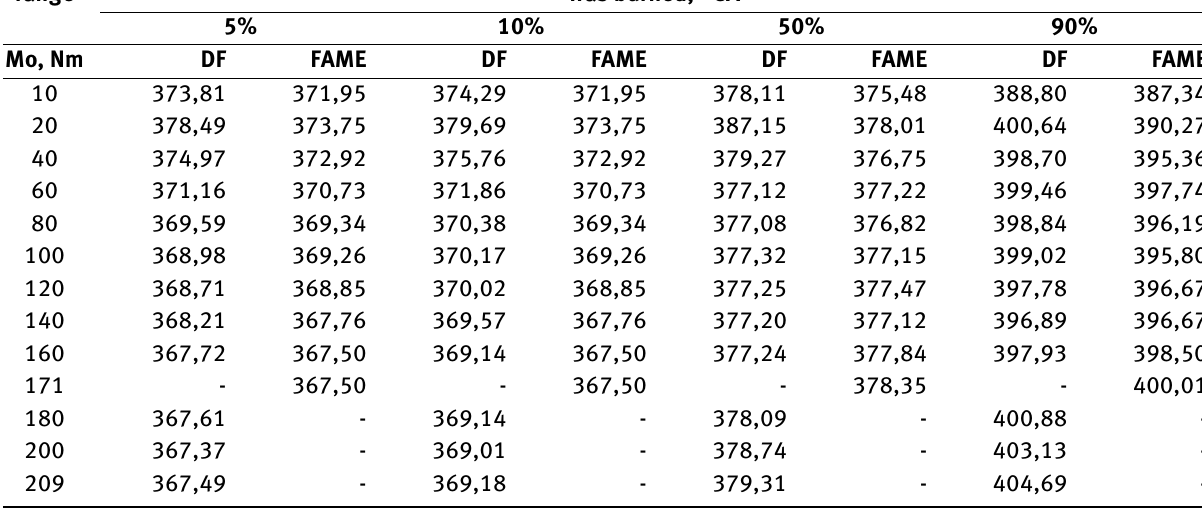
Table 4: Angular values of crankshaft rotation of the engine at which 5, 10, 50 and 90% of the fuel dose was burned in the Fiat 1.3 MultiJet engine cylinder working according to the load characteristics for n = 1750 rpm, supplied with the following fuels: FAME, DF